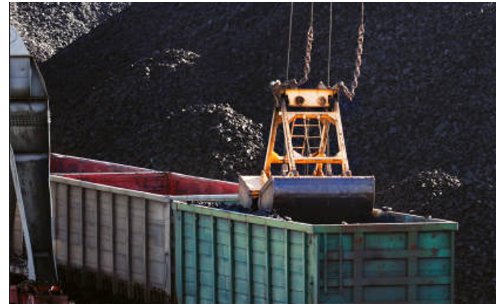
Figure 1. Automated crane loading of a train car.